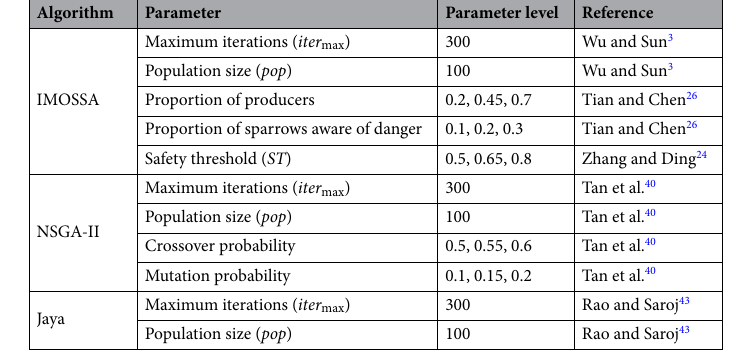
Table 4. Parameters used in the metaheuristic